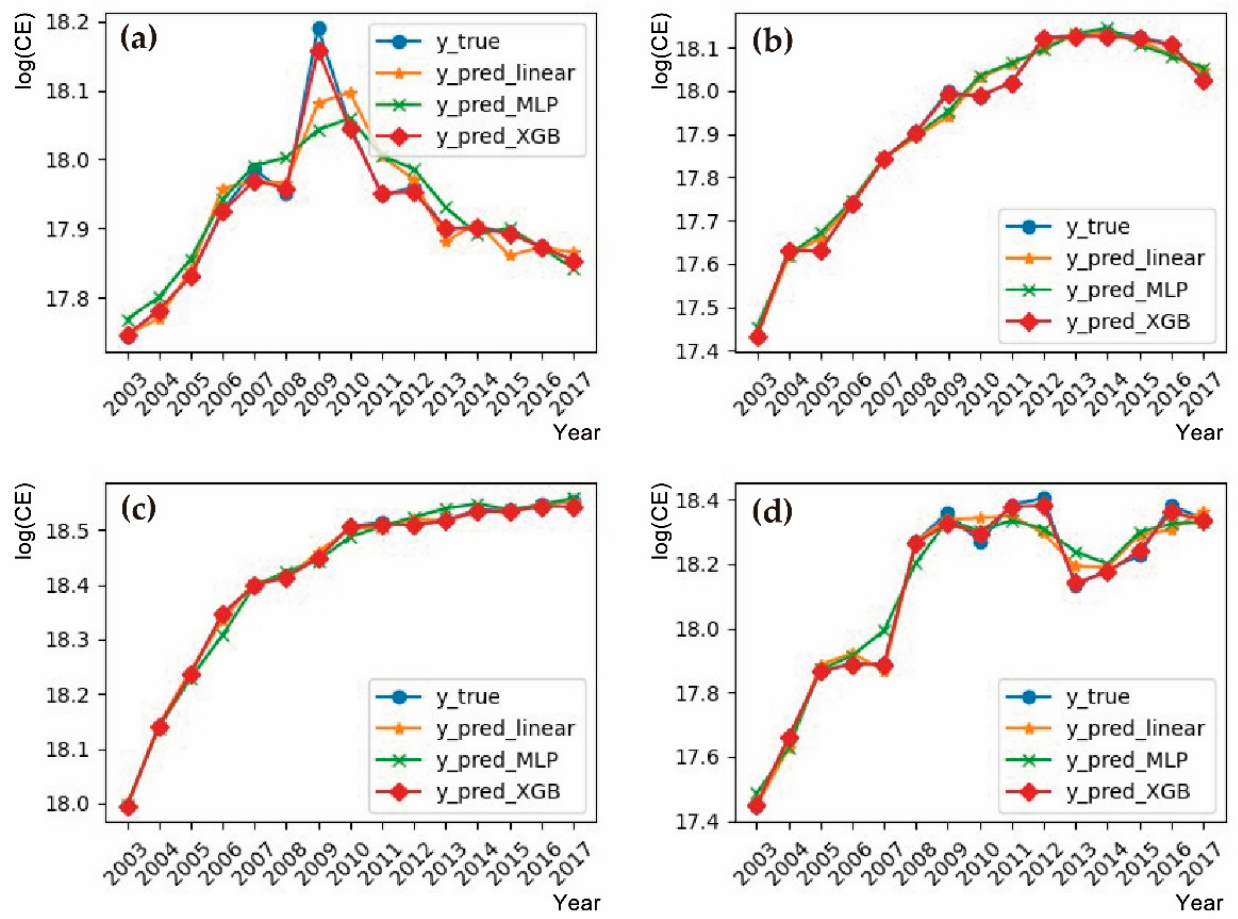
Figure 2. CE and influence factors regression results using XGBoost. ( a ) Beijing; ( b ) Tianjin; ( c ) Shanghai; ( d ) Chongqing.